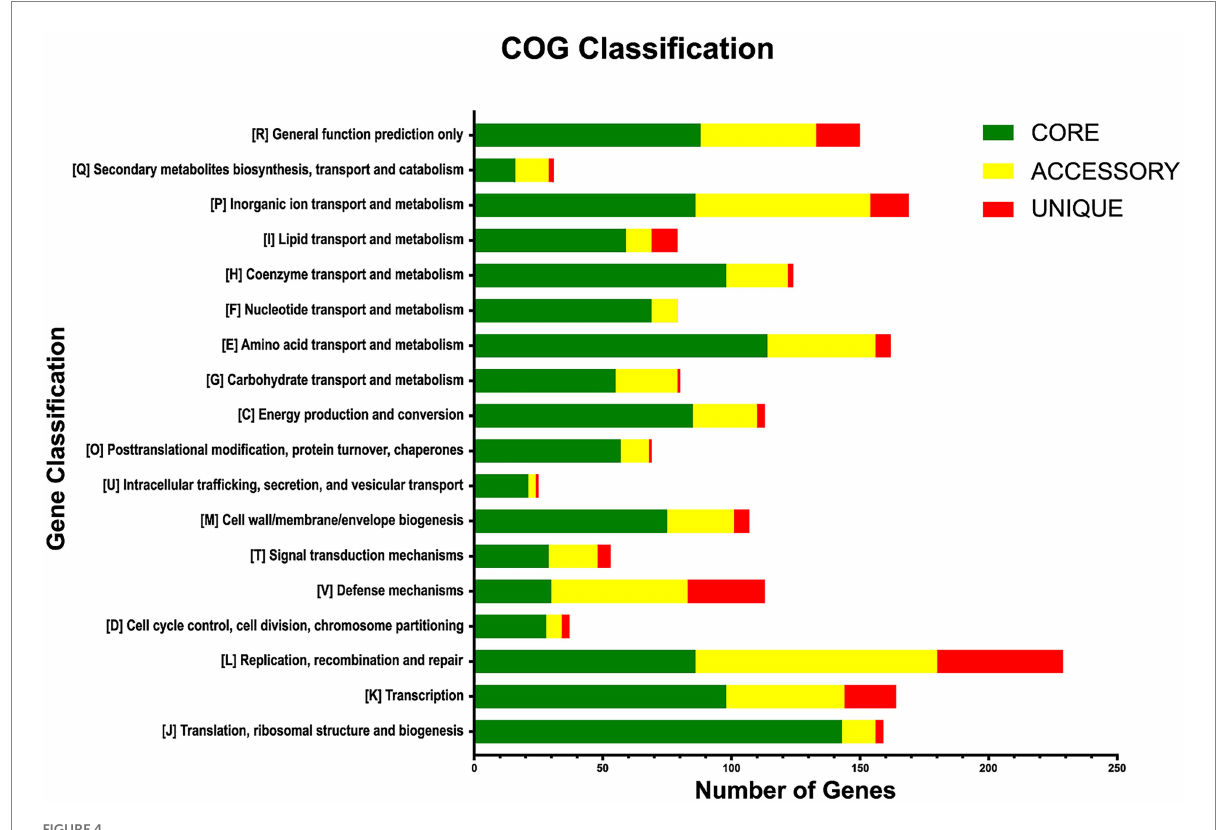
FIGURE 4 Functional annotations of the pan-genome subsets according to COG categories.